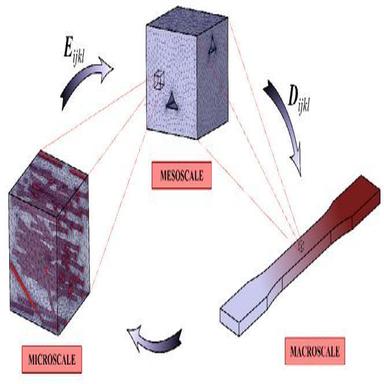
Three-scale homogenization framework.